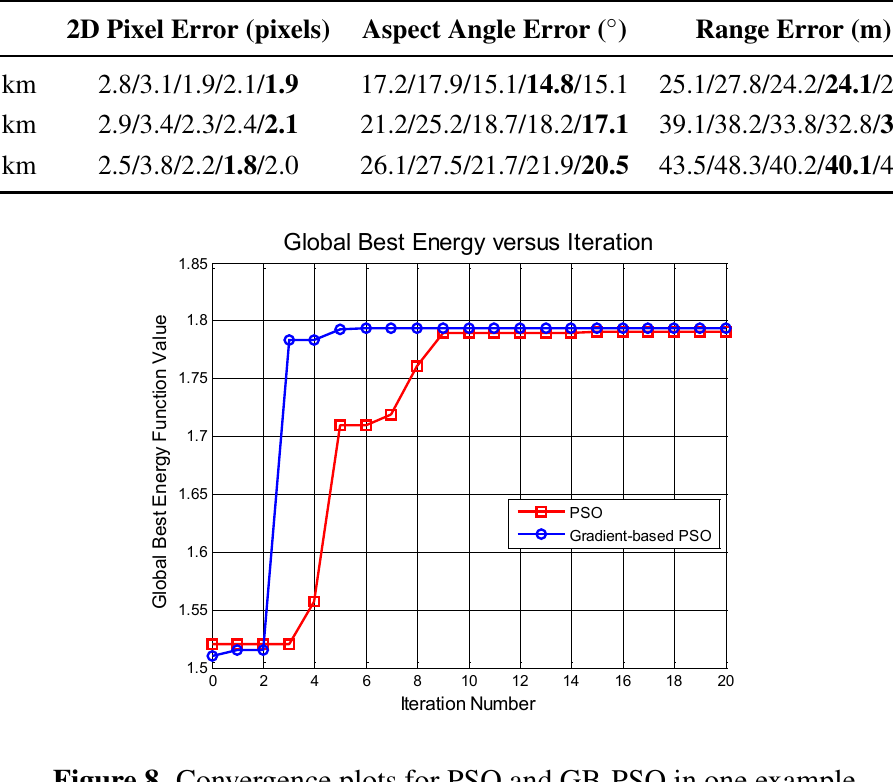
Figure 8. Convergence plots for PSO and GB-PSO in one